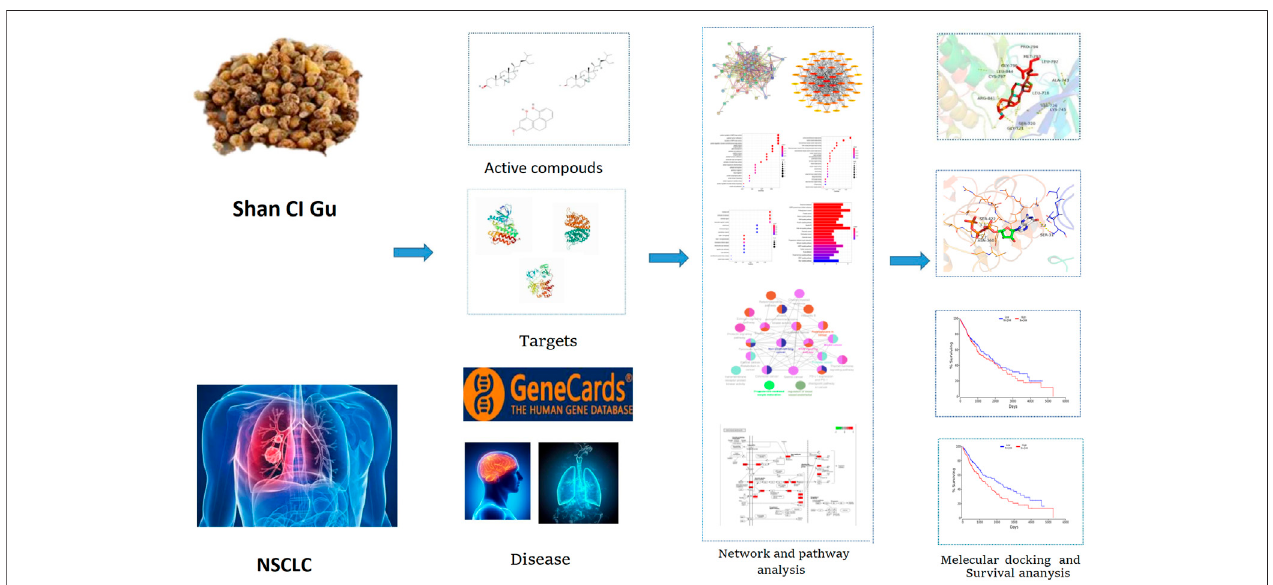
FIGURE 1 | Technological